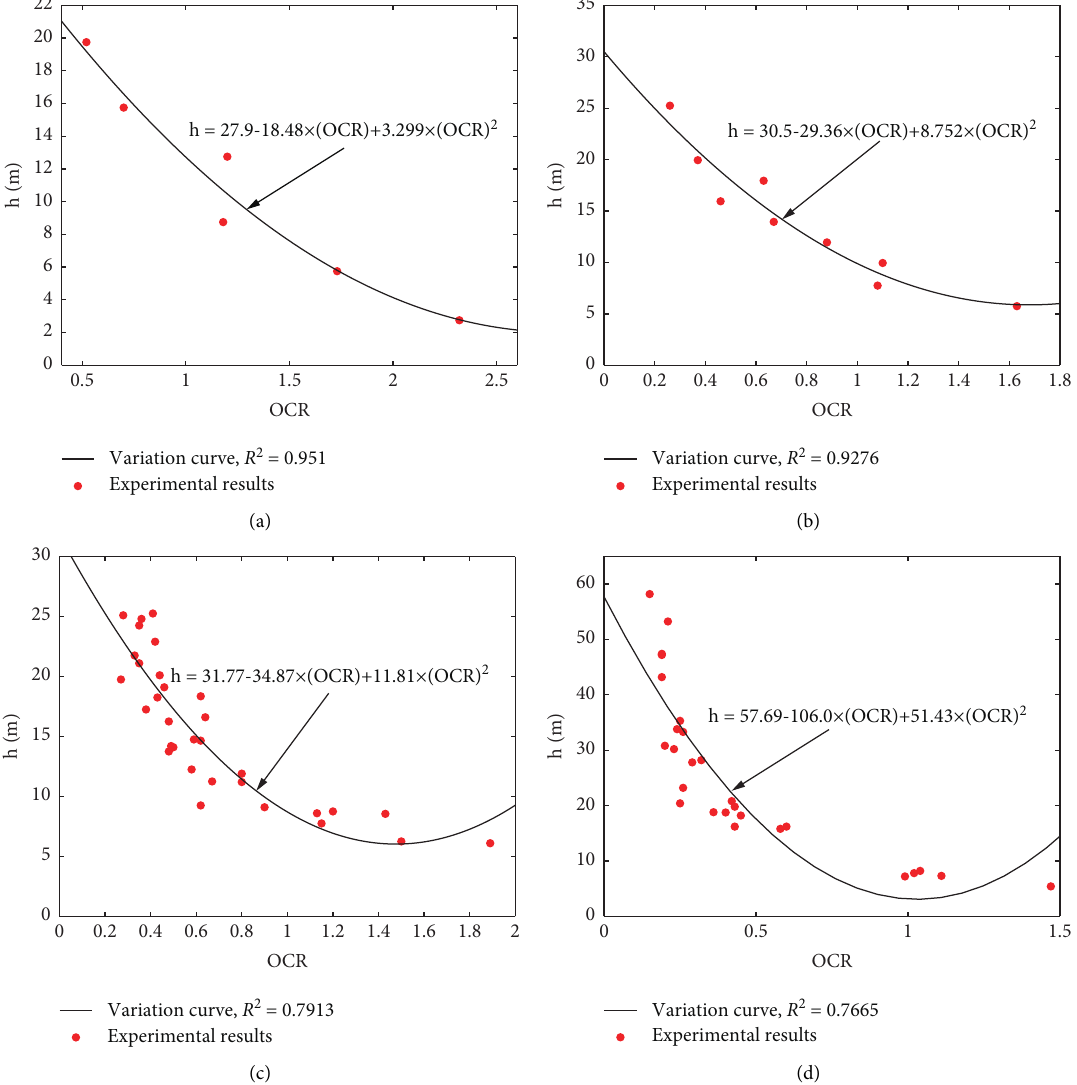
Figure 4: Variation curve of overconsolidation ratio with the depth in Zhuhai silt layer. (a) Project 1, (b) project 2, (c) project 3, and (d) project